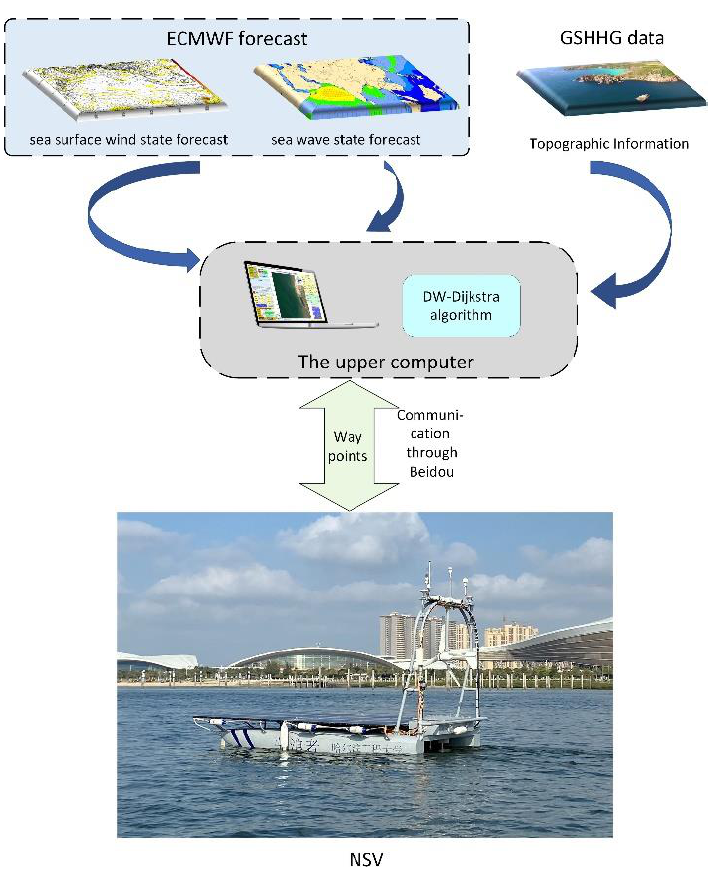
Figure 6. Dynamic path planning methods in time-changing wind field environments.